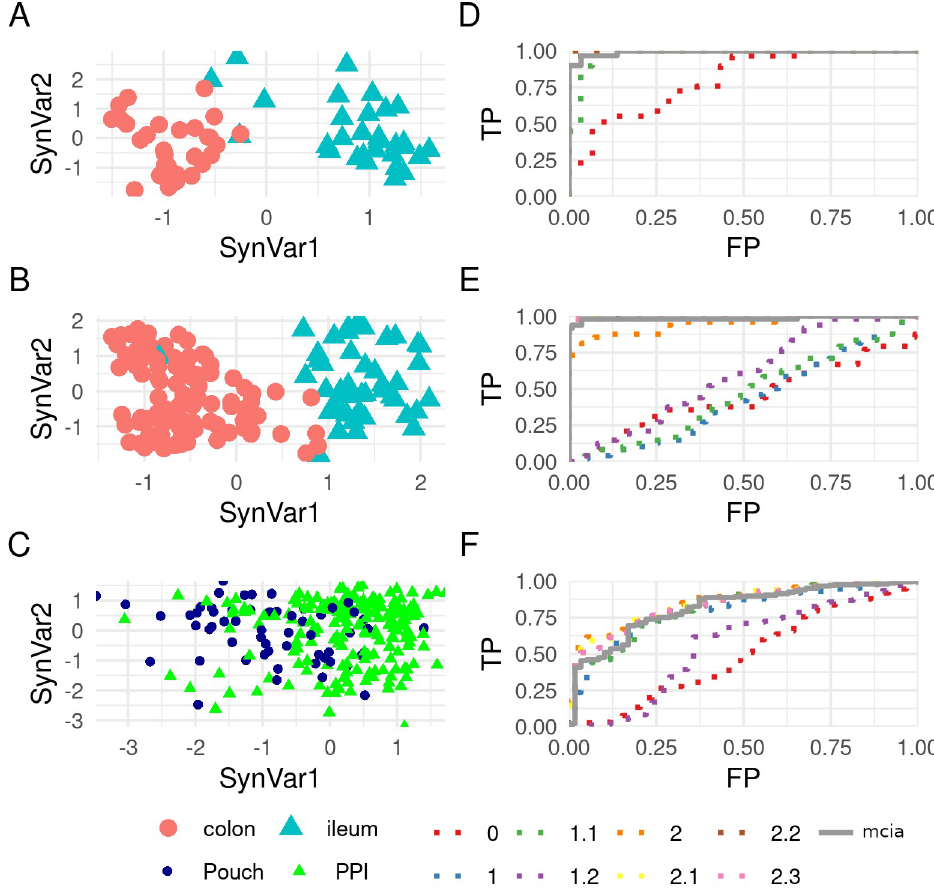
Fig 7. Multiple co-inertia analysis and area under the curve for the location of the Crohn’s disease/ulcerative colitis, the hematopoietic stem cell transplant Crohn’s disease and pouchitis dataset. A, B, C plots are the results of applying multiple co-inertia analysis (MCIA) where the horizontal and vertical axis represent the synthetic variable 1 and 2 respectively. D, E, F plots are the area under the curve (AUC) for all the methods applied on this dataset. The first row (A, D) is the analysis of CD/UC dataset, the second one (B, E) the HSCT CD dataset, and the third one (C, F) the pouchitis